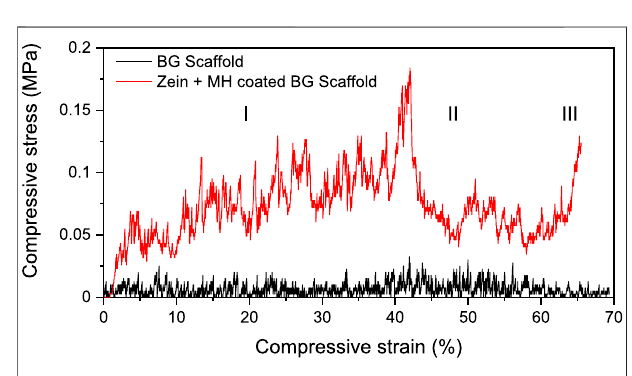
FIGURE 4 | Representative stress-strain curves for coated and uncoated BG